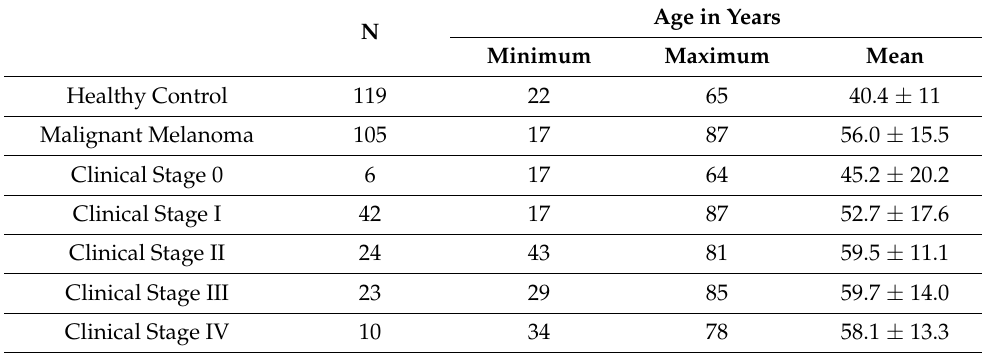
Table 3. Descriptive statistics of the study